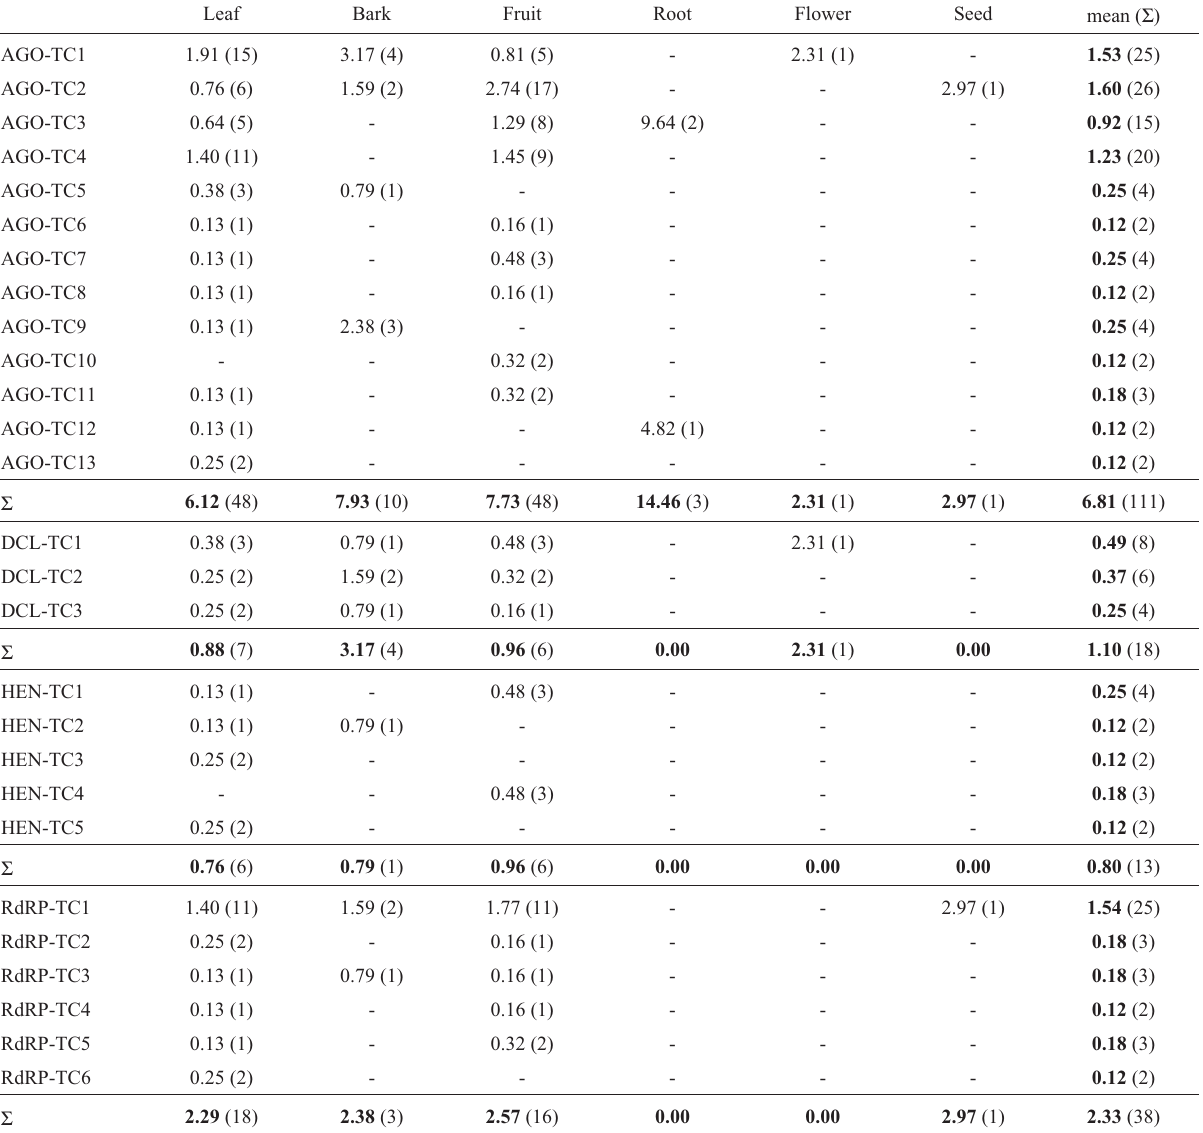
Table 1 - Abundance of reads grouped into tentative consensi (TC) of genes involved in RNA silencing pathways per tissue in selected libraries from the CitEST database a . Frequency is given per 10,000 transcripts and absolute numbers of valid reads are shown in parentheses. Leaf Bark Fruit